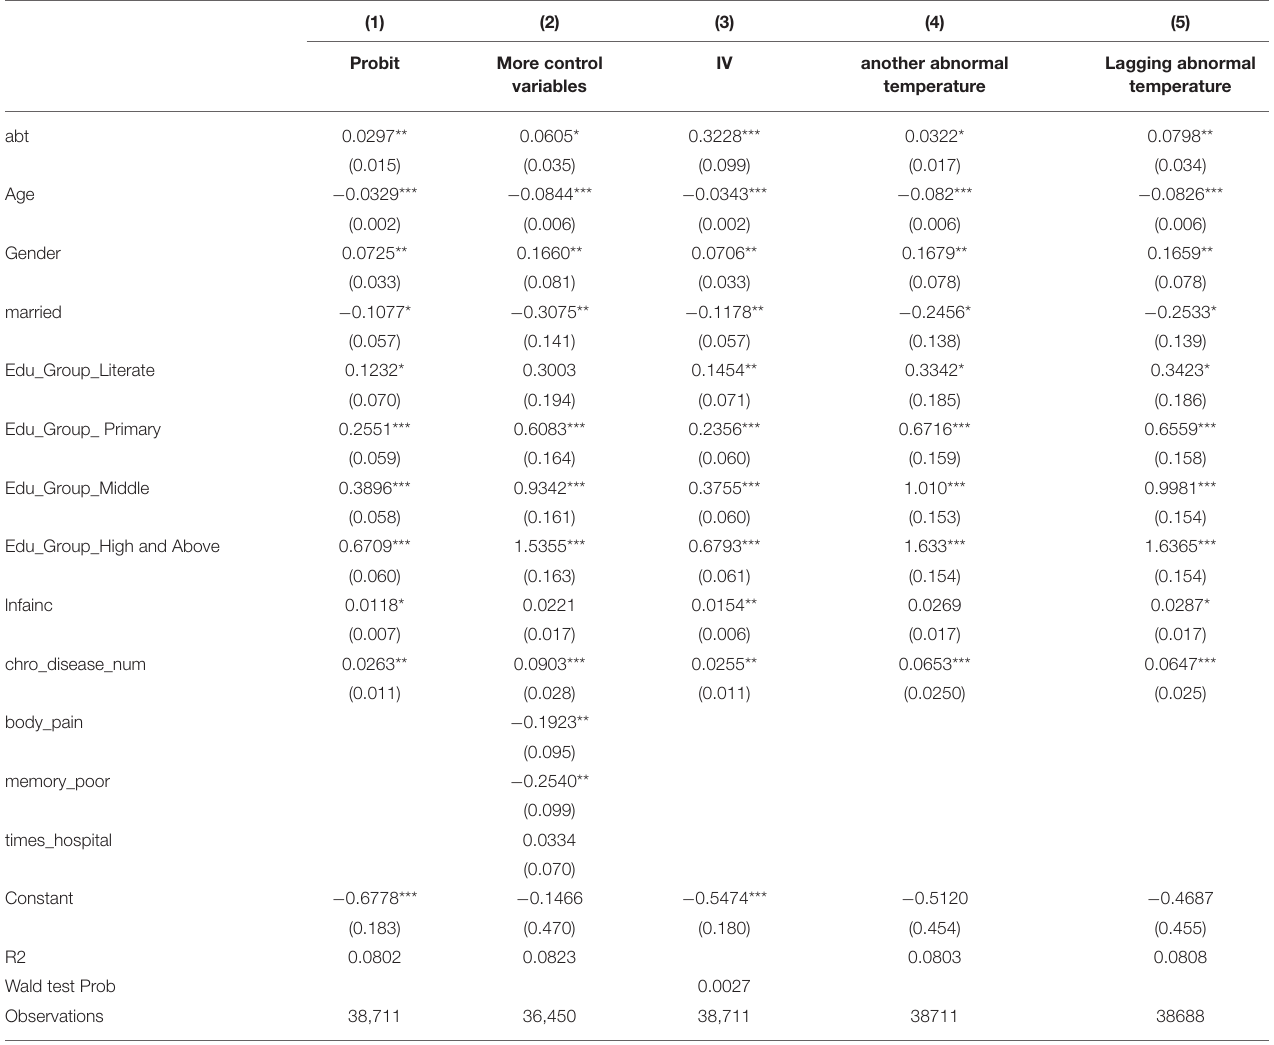
TABLE 4 | Robustness